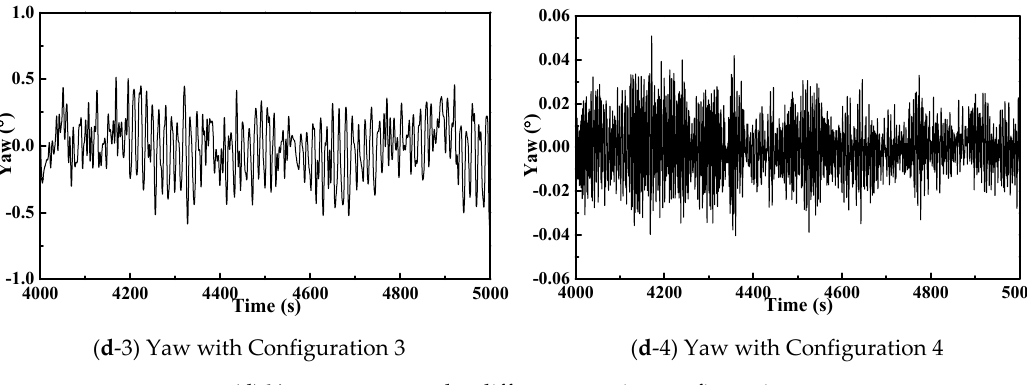
Figure 3. Time series of the platform motion under different mooring configurations.